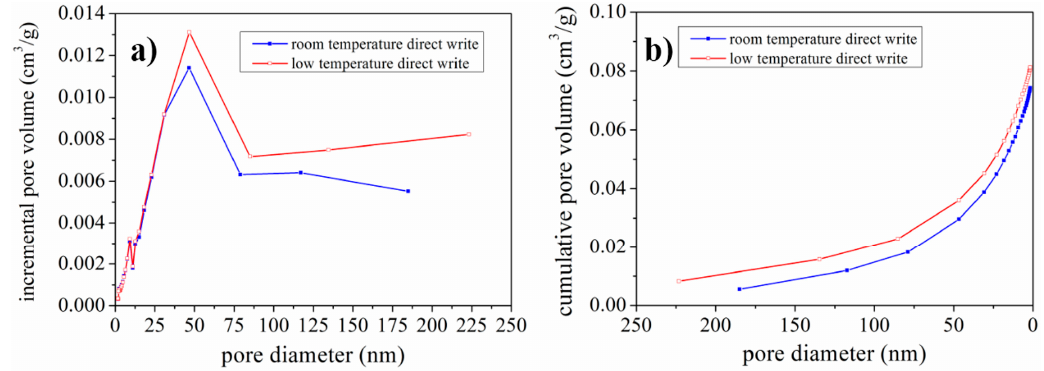
Figure 10. Pore size and distribution measured by nitrogen adsorption: ( a ) incremental pore volume variation with pore diameter; ( b ) cumulative pore volume variation with pore diameter.